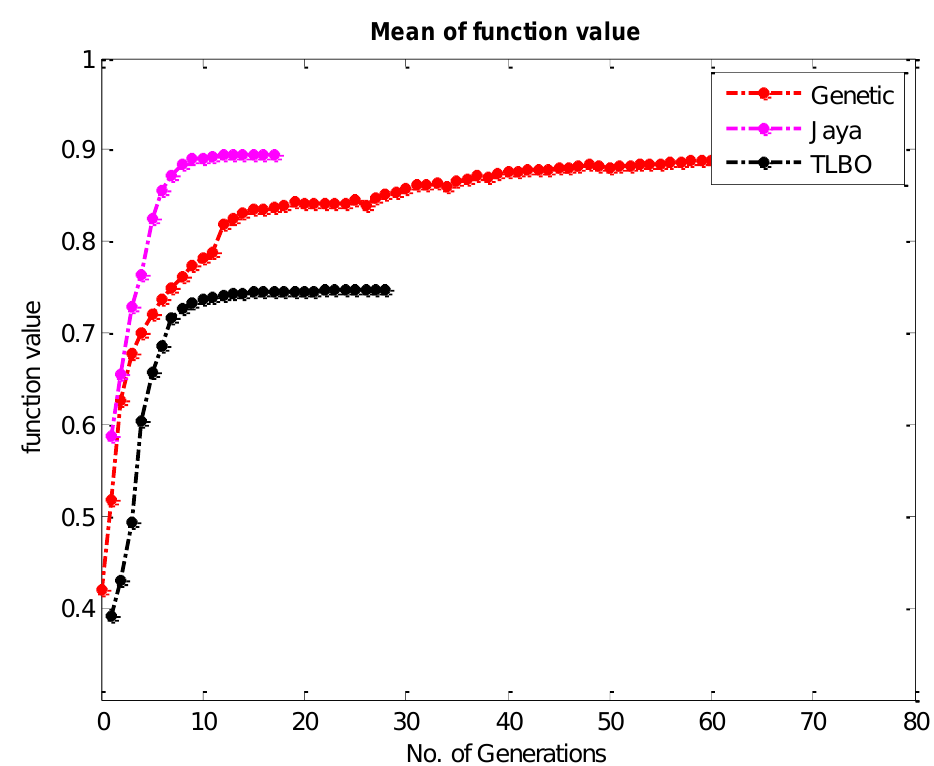
Figure 11. Convergence plot for the MPCI by ( a ) TLBO ( b ) JAYA & ( c ) Genetic Algorithm.